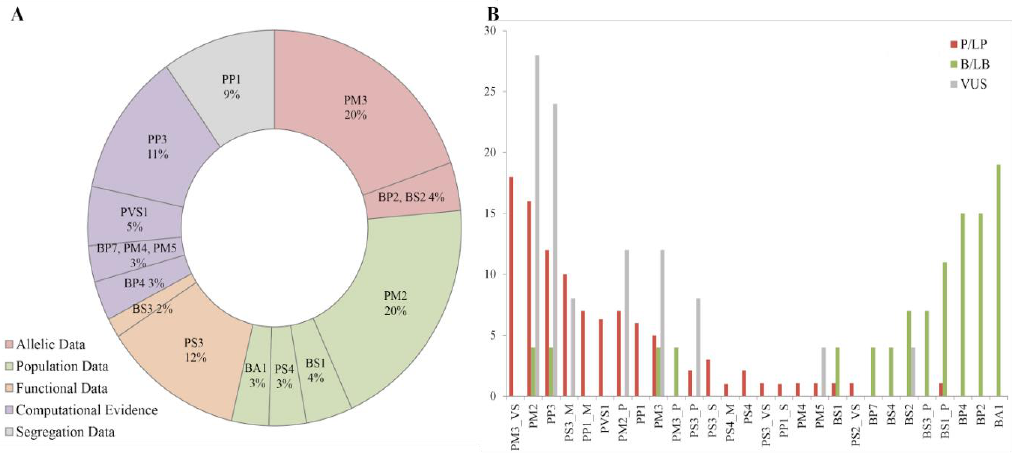
Figure 5. Frequency of rules applied during curation procedure. ( A ). PM2 and PM3 were the most frequently criteria applied (corresponding to population and allelic data), along with the PS3 rule, which included functional studies demonstrating a deleterious effect. ( B ). ACMG/AMP and HL-EP rules correspondence with final classification. Red, grey and green colors indicate the final variant interpretation (P/LP, B/LB and VUS) when the rule was applied. Some criteria demonstrate a bigger weight in the classification of variants. Rules applied with a modified strength are denoted by the rule followed by _P for Supporting, _M for Moderate, _S for Strong, and _VS for Very Strong.